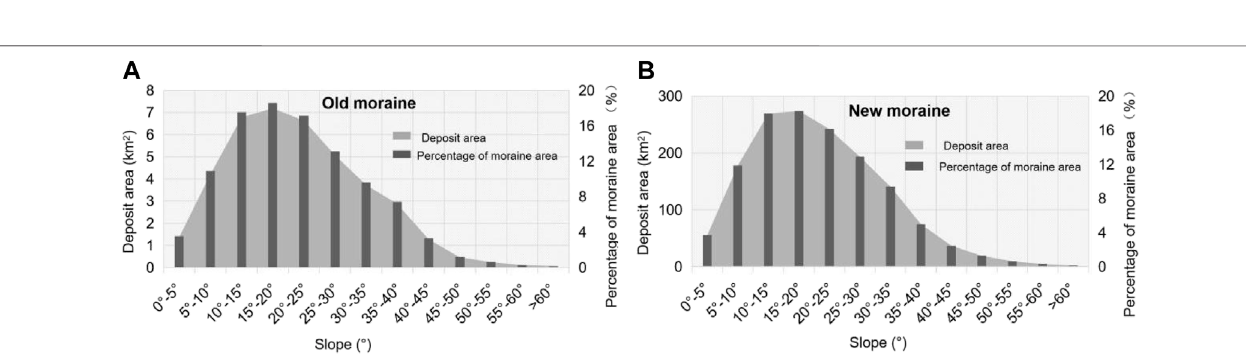
Frontiers in Earth Science |